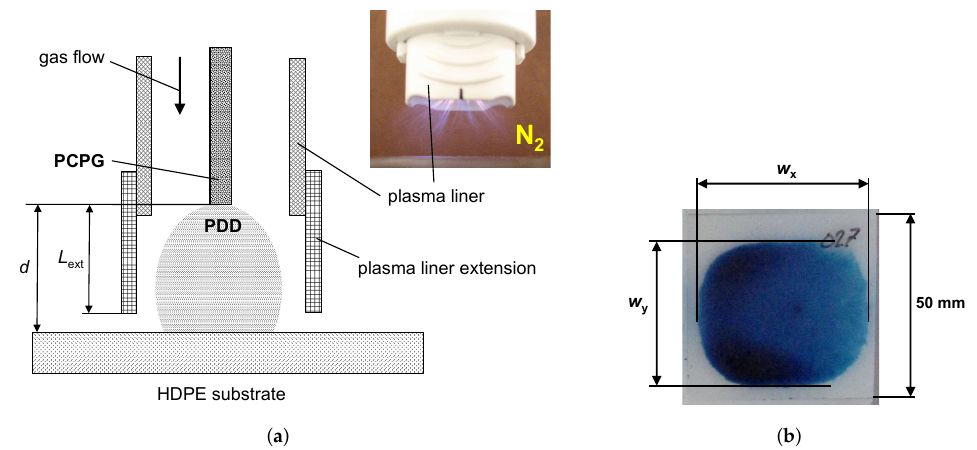
Figure 1. Surface activation. ( a ) Setup for activation of the polymer substrate surface, where the distance d means the distance between the substrate and the tip of the PCPG, L ext is the effective length of the plasma liner extension, and ( b ) is the visualization of a typical activation area with SFE ≥ 58 mN/m produced by 10 s nitrogen PDD at a distance d = 3.5 mm, nitrogen flow of 8 SLM and PCPG input power of 8.0